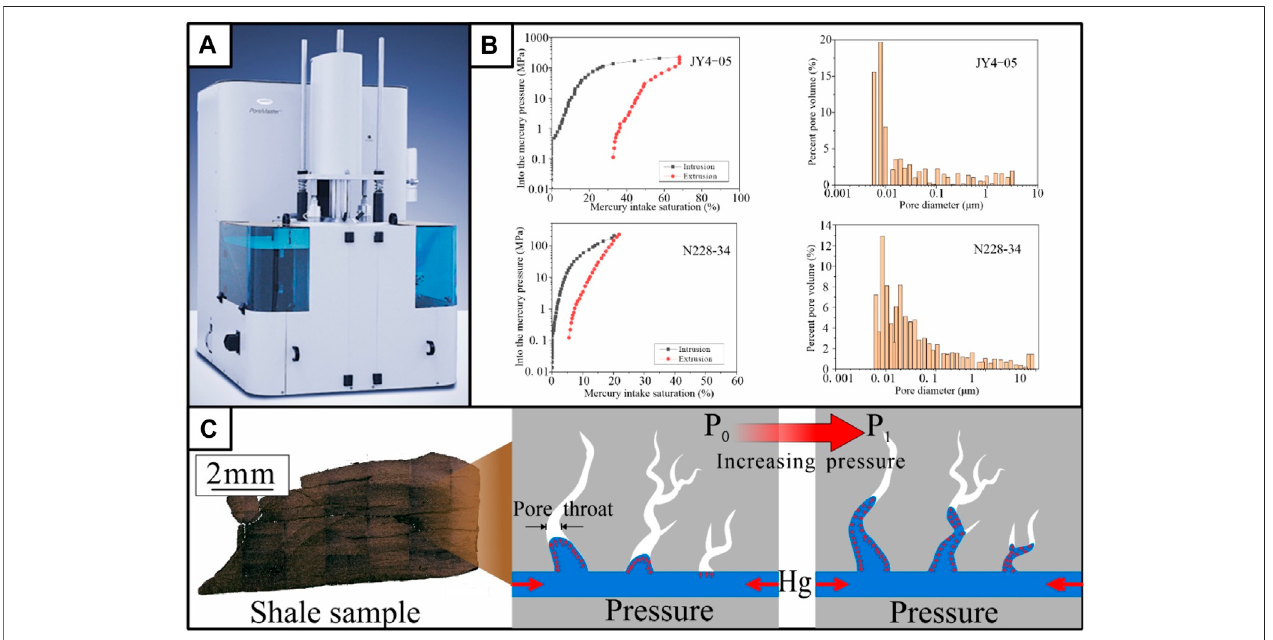
FIGURE7| Basicworkingprincipleofmercuryintrusionporosimetry(MIP). (A) Experimentalapparatus; (B) MIPdatacurves ofdifferentshalesamplesanditspore distributioncharacteristics(JY4-05andN228-34(LongmaxiFormation,3,397.87 m));and (C) Schematicdiagramofmercuryinjectingporethroatinmassiveshale(JY4- 09, Longmaxi Formation, 2585.7